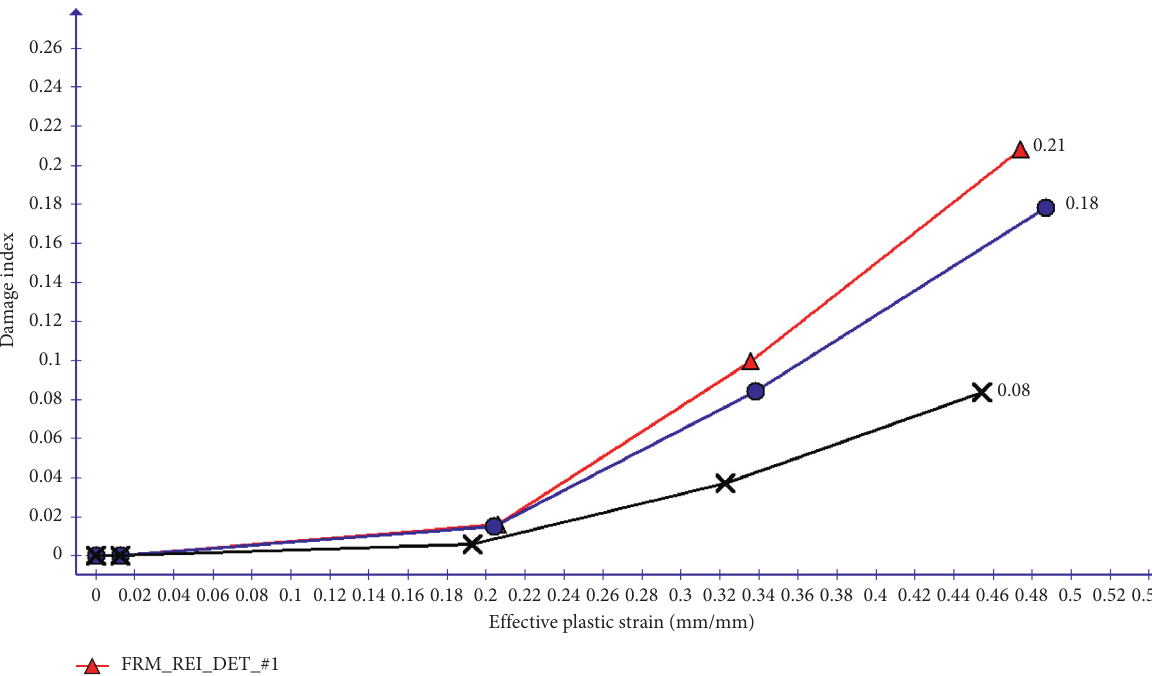
Figure 19: Column damage index vs. effective plastic strain plot for 46kg TNT explosive located at 1 st story ground floor slab.